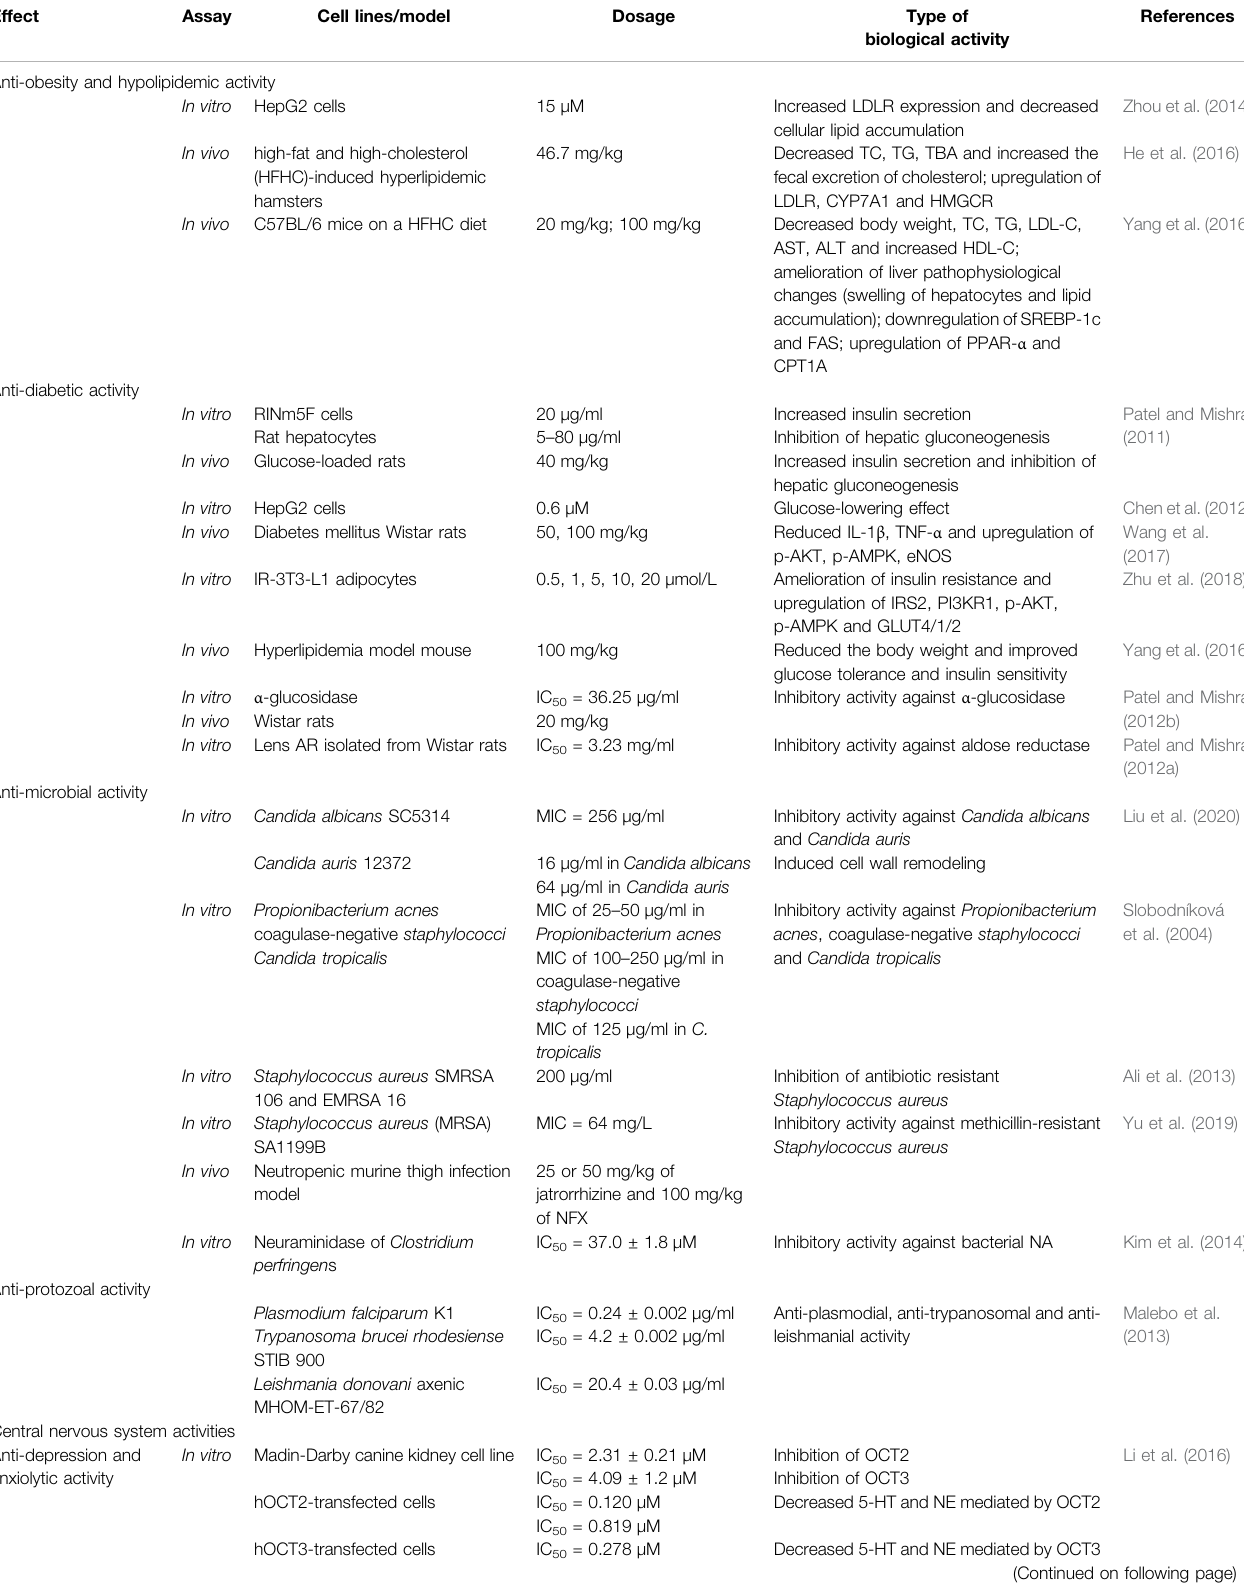
TABLE 2 | Anti-diabetic, antimicrobial, antiprotozoal, and central nervous system activities and mechanisms of jatrorrhizine in in vitro and in vivo